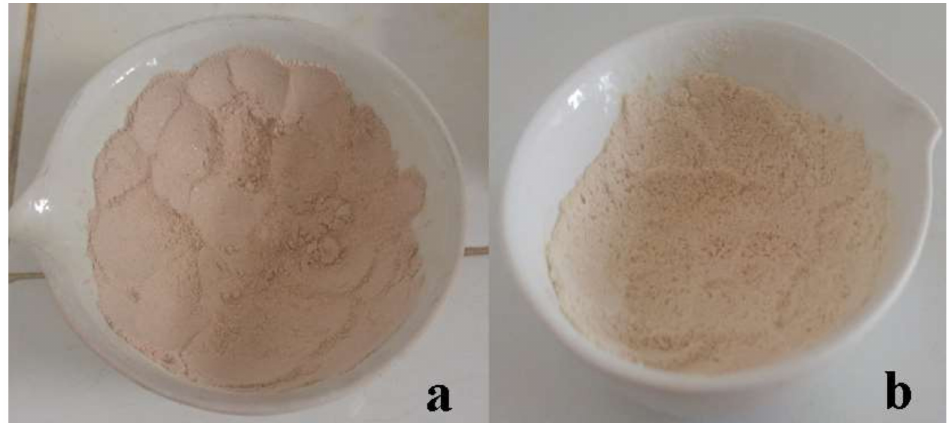
Figure 5. ( a ) CaCl 2 + K-Feldspar mixture before roasting. ( b ) CaCl 2 + K-Feldspar mixture after roasting.